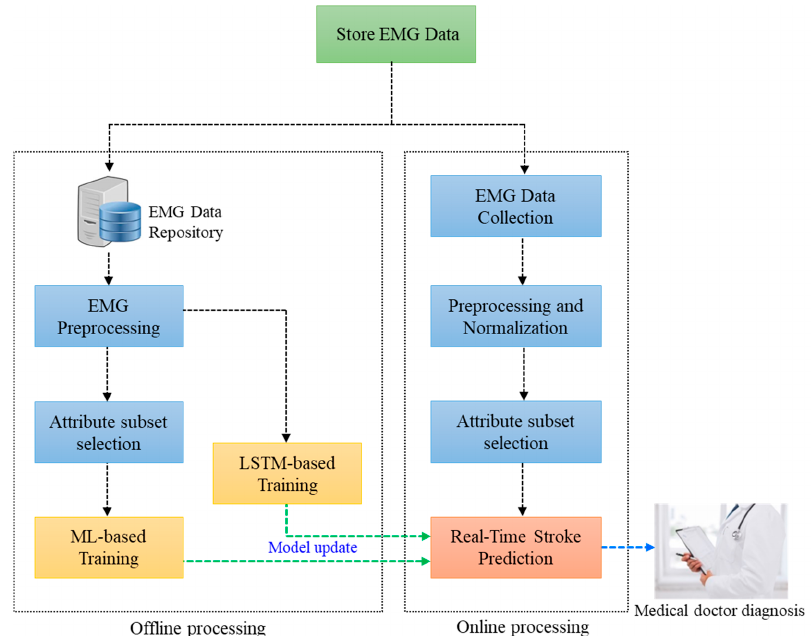
Figure 1. Overall structural diagram of AI-based stroke disease prediction system using EMG bio-